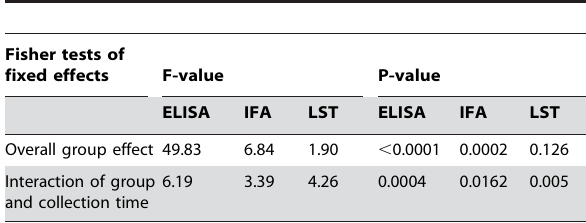
Table 8. Summary of mixed model analysis of ELISA, IFA and the Lymphocyte Stimulation Test